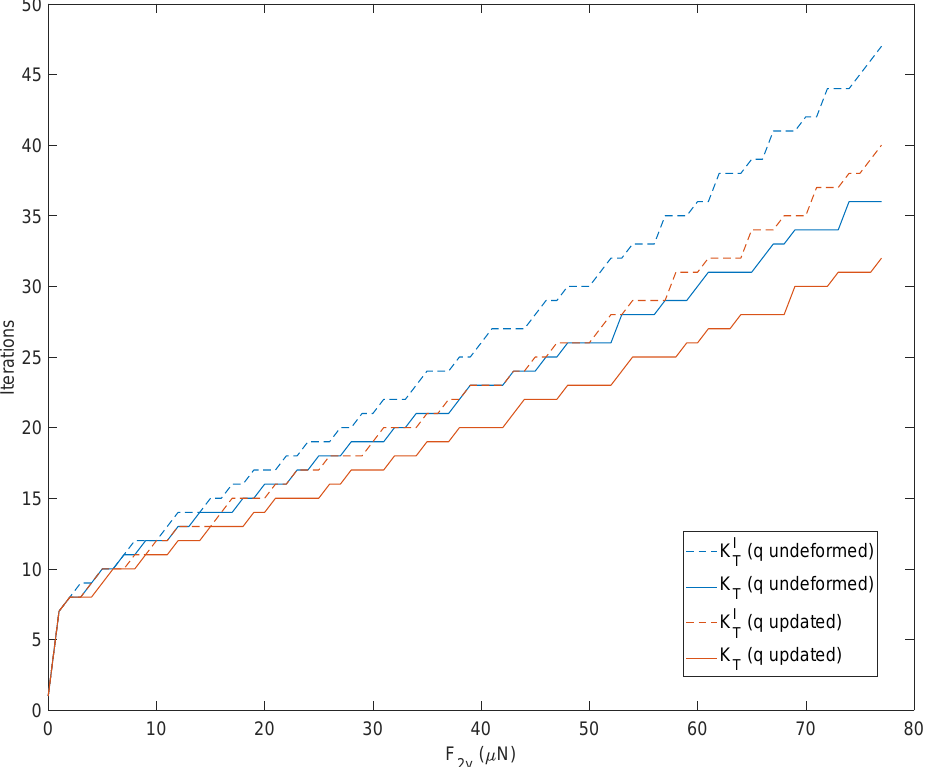
Figure 12. Number of iterations to achieve convergency of the direct kinetostatic analysis varying the input force. The simulation compares four strategies to upload the tangent stiffness matrix: considering the complete matrix K T or only the first term K I undeformed solution, considering the complete matrix K T or only the first term K I simulation from the previous converged